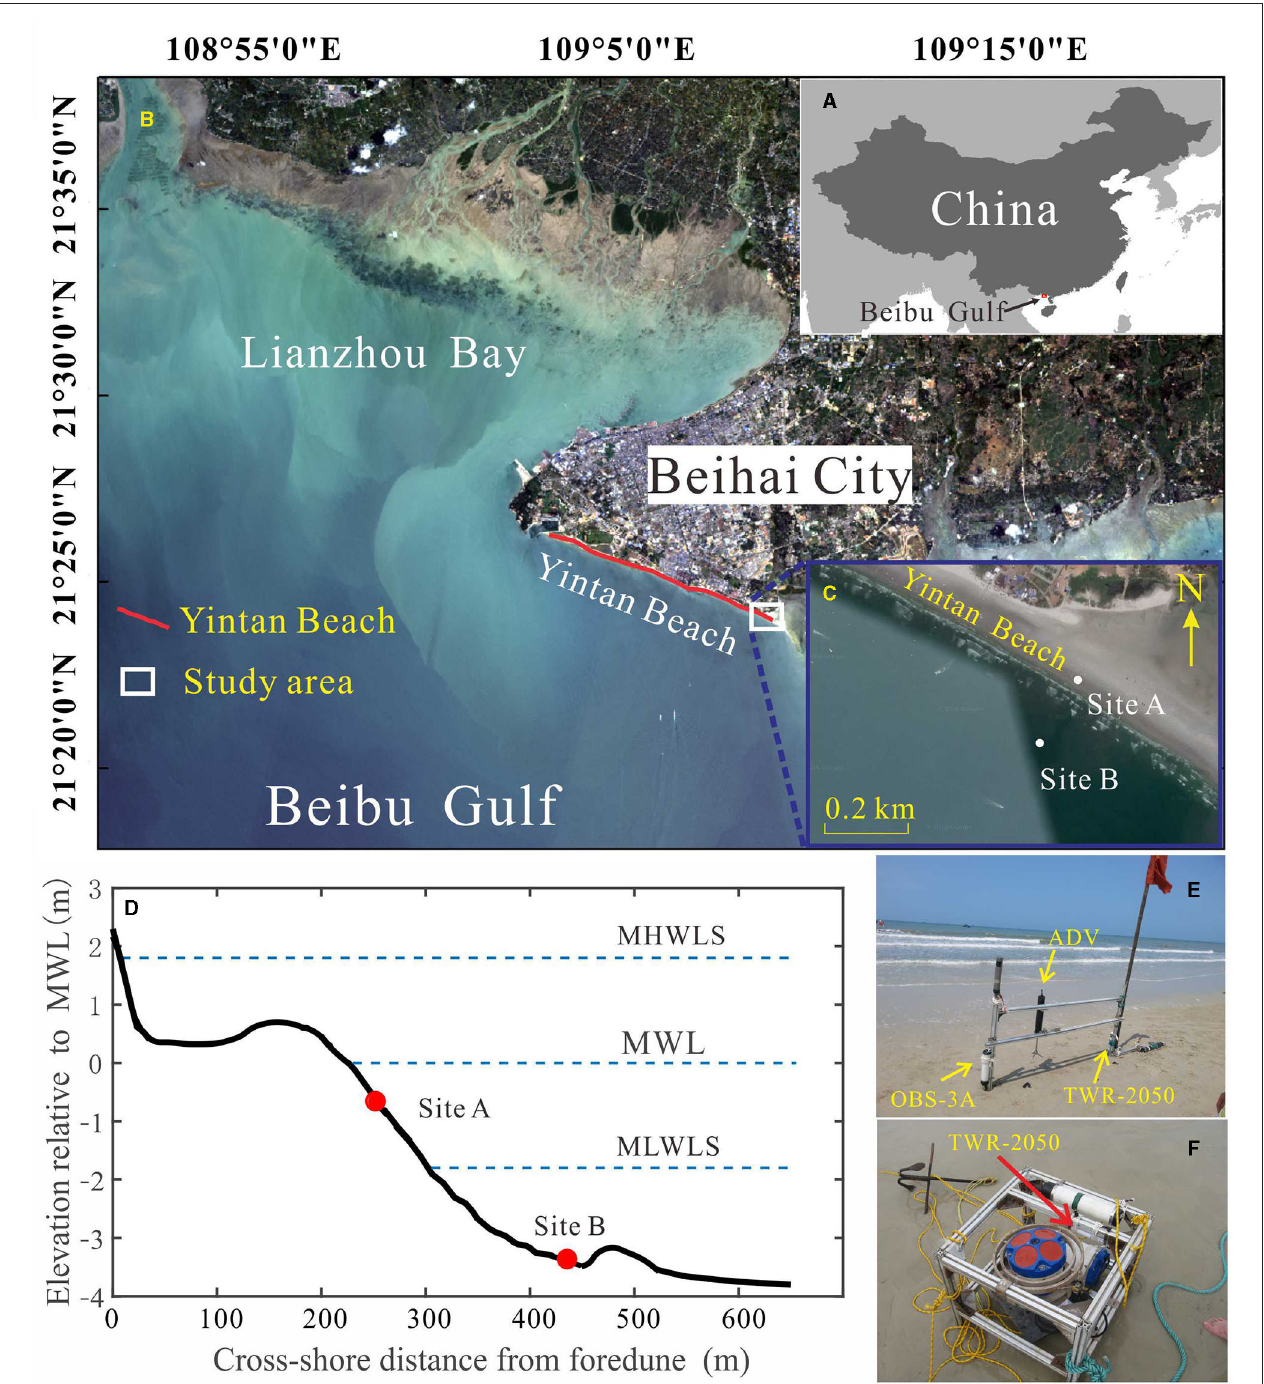
FIGURE 1 | Study area and instrument deployment. (A) The location of Beibu Gulf; (B) the location of Yintan Beach and (C) the study area of Yintan Beach with the location of instrument sites. (D) Beach profile of the instrument sites at the beginning of the field observation and the cross-shore location of Site A and Site B (x = 0 indicated the foot of foredune), with the three horizontal, dashed lines representing the mean high water level of spring tides (MHWLS), mean water level (MWL), and mean low water level of spring tides (MLWLS), respectively; (E) instrument deployment upon the aluminum frame at Site A and (F) the deployment of Tide & Wave Recorder-2050 (TWR-2050) upon the aluminum quadripod at Site